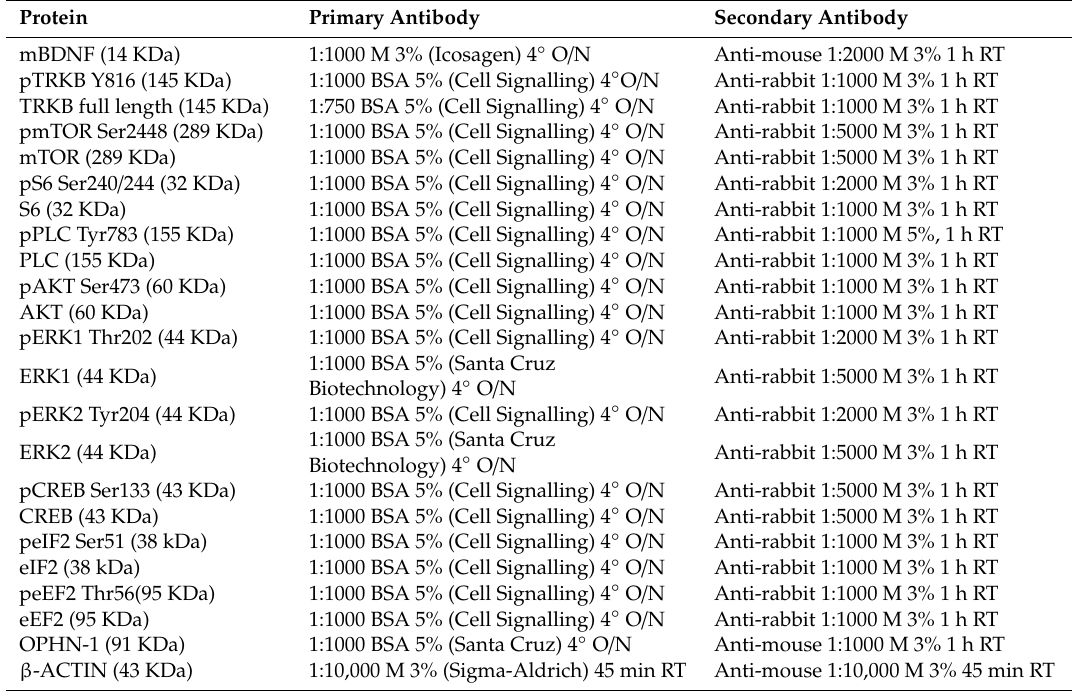
Table 2. antibodies condition used in the western blot analyses. Over / Night (O / N); Room Temperature (RT); Milk (M); Bovine serum albumin